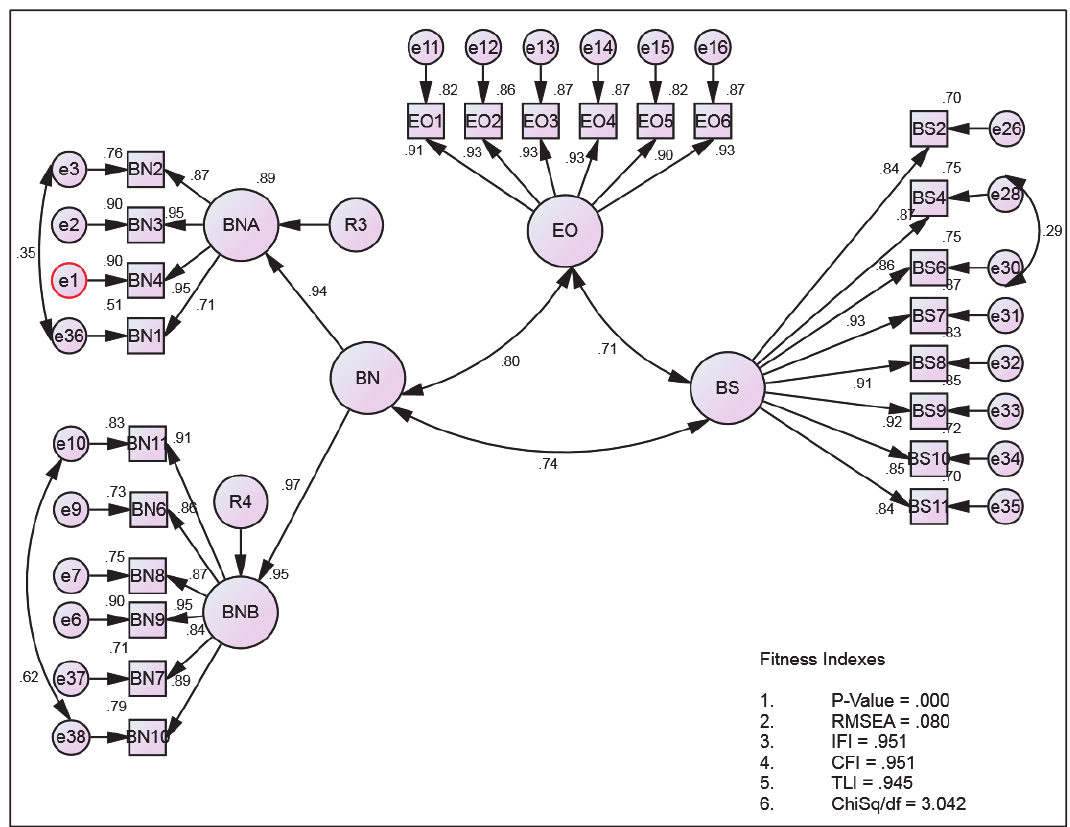
Fig. 2. CFA Diagram for the